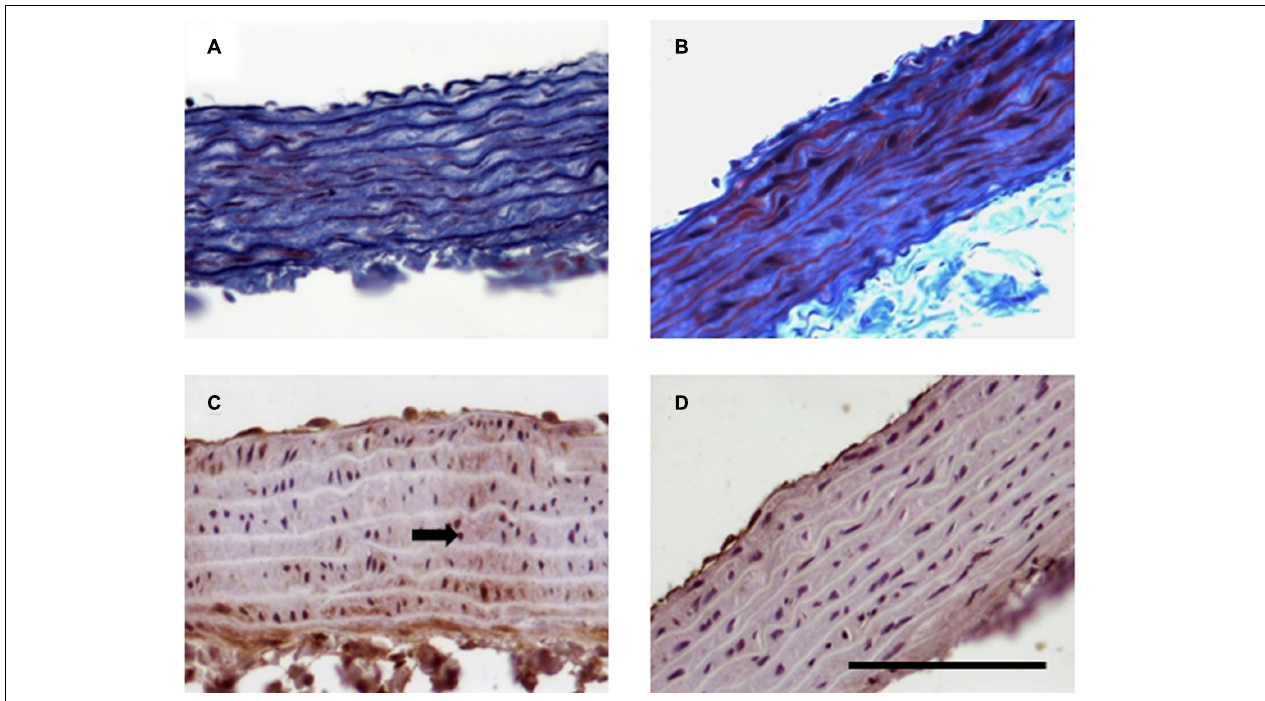
FIGURE 8 | Representative images of histology and immunohistochemistry of the effect of cisplatin treatment on rat aorta. Rats were injected intraperitoneally for 5 weeks with saline (0.9% NaCl, left column) or cisplatin (3 mg/kg week − 1 , right column). Histological samples embedded in paraffin and stained with Masson’s trichrome (A,B) . Samples processed for immunohistochemistry with anti eNOS antibody (C,D) . Bar: 100 µ